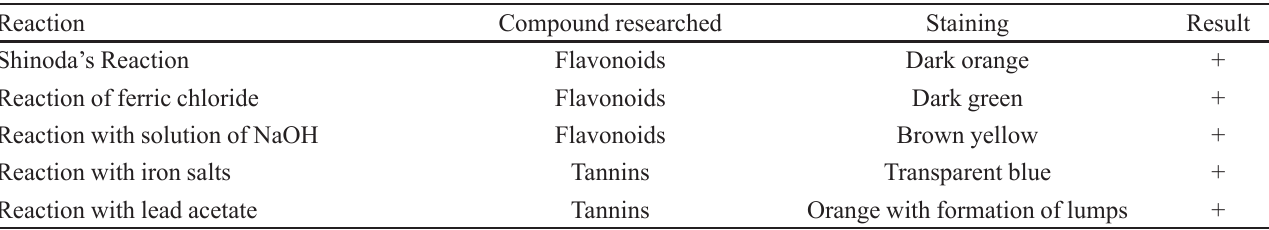
TABLE I - Results of the phytochemical characterization of the green tea glycolic extracts. The symbols (+) indicates a positive